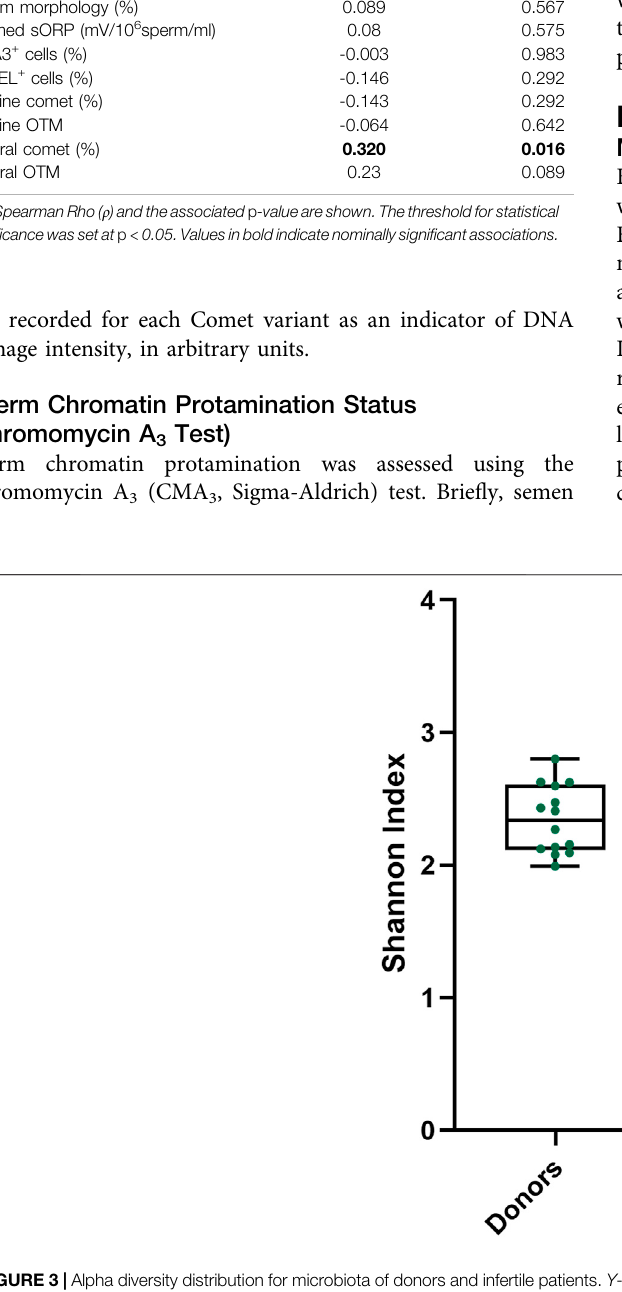
FIGURE 3 | Alpha diversity distribution for microbiota of donors and infertile patients. Y -axis represents the Shannon index of the groups displayed at the X -axis. Thin horizontal lines delimit the 95% con fi dence interval (CI), whereas the thick horizontal mark denotes the median value.